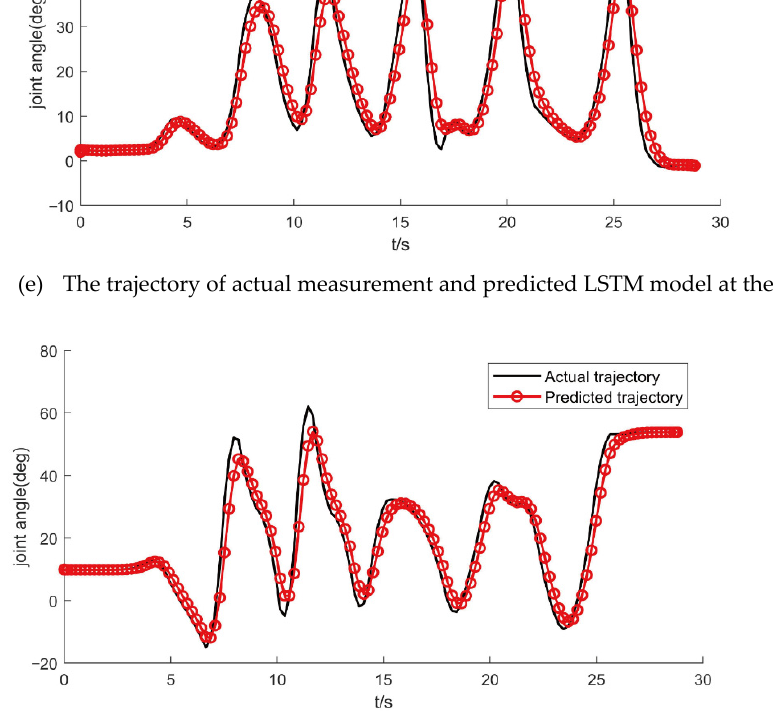
Figure 7. The actual trajectory with wearable joint angle measurement device and predicted trajectory with observation update LSTM model.